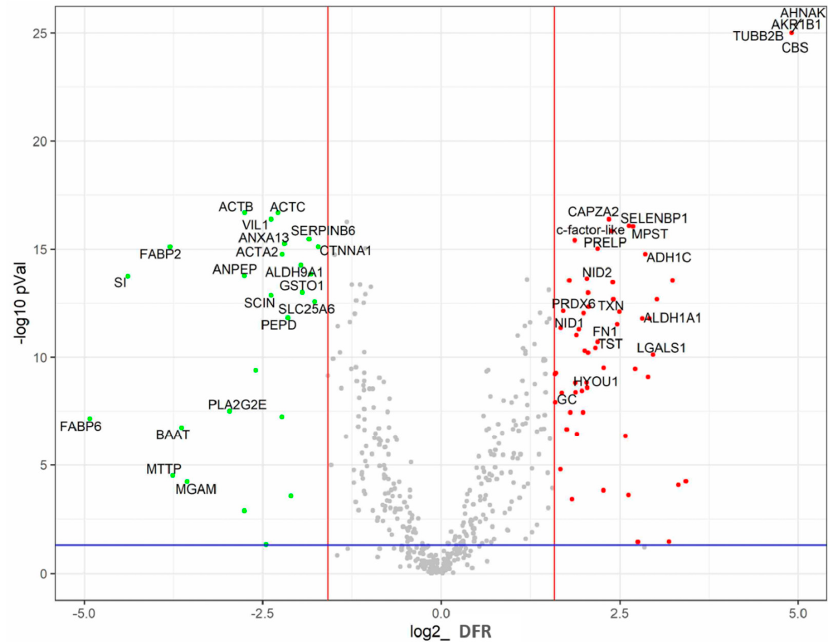
Figure 1. Volcano plot showing protein expressed in the caecum and ileum. Differential expressions presented as log2 of the ratio (X axis) are plotted against p values of each comparison. Coloured dots represent proteins fulfilling a threefold difference in abundance in the caecum or ileum and p -value < 0.05: green dots—proteins more abundant in the ileum; red dots—proteins more abundant in the caecum. Overall, 20 differentially expressed and the most abundant proteins in the ileum or caecum are identified. For the whole dataset, see Supplementary File S2. Position of FABP6 as ileum-specific protein and AHNAK, AKR1B1, TUBB2B, and CBS as caecum-specific proteins along the X axis does not represent their differential fold ratio as these proteins were highly specific for the ileum or caecum, respectively (see text below). Table 1. Top 20 ileum-specific proteins ranked by abundance.